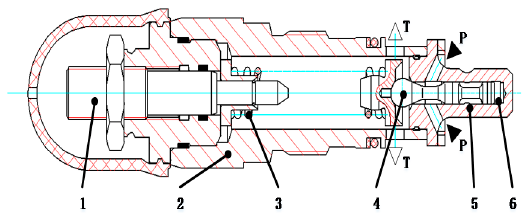
Figure 4. The insert part structure of DBD type relief valve.